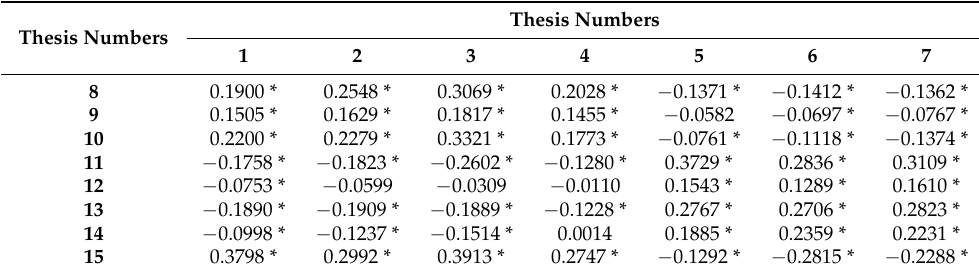
Table 4. Pearson’s correlation coefficients between the assessments of theses diagnosing the percep- tion of climate change and the perception of renewable